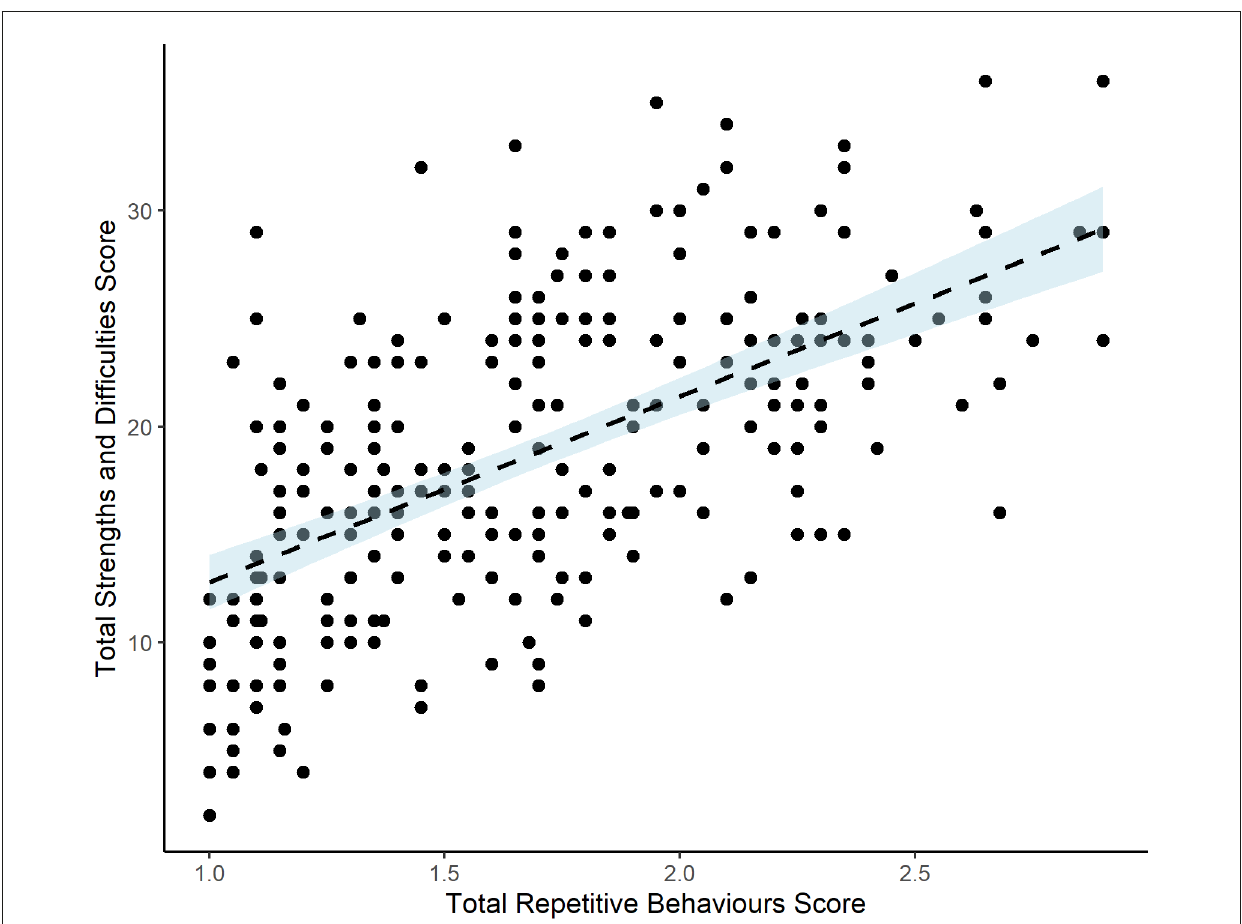
FIGURE2 Repetitive behaviors and emotional and behavioral difficulties. Scatterplot showing relation between total repetitive behavior score and total strengths and difficulties score. Note: Each dot represents an individual participant. For RBQ-2 Total Score, scores of 1 (never/rarely) to 3 (marked/notable) are averaged across 20 items. Note that there is no cut-off score but the 10th percentile and 1 standard deviation from the mean are 2.35 and 2.17